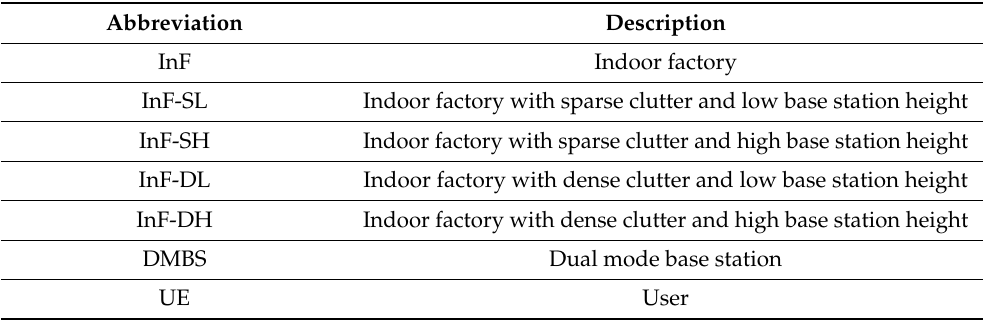
Table 2. Abbreviations used for indoor factory scenario.